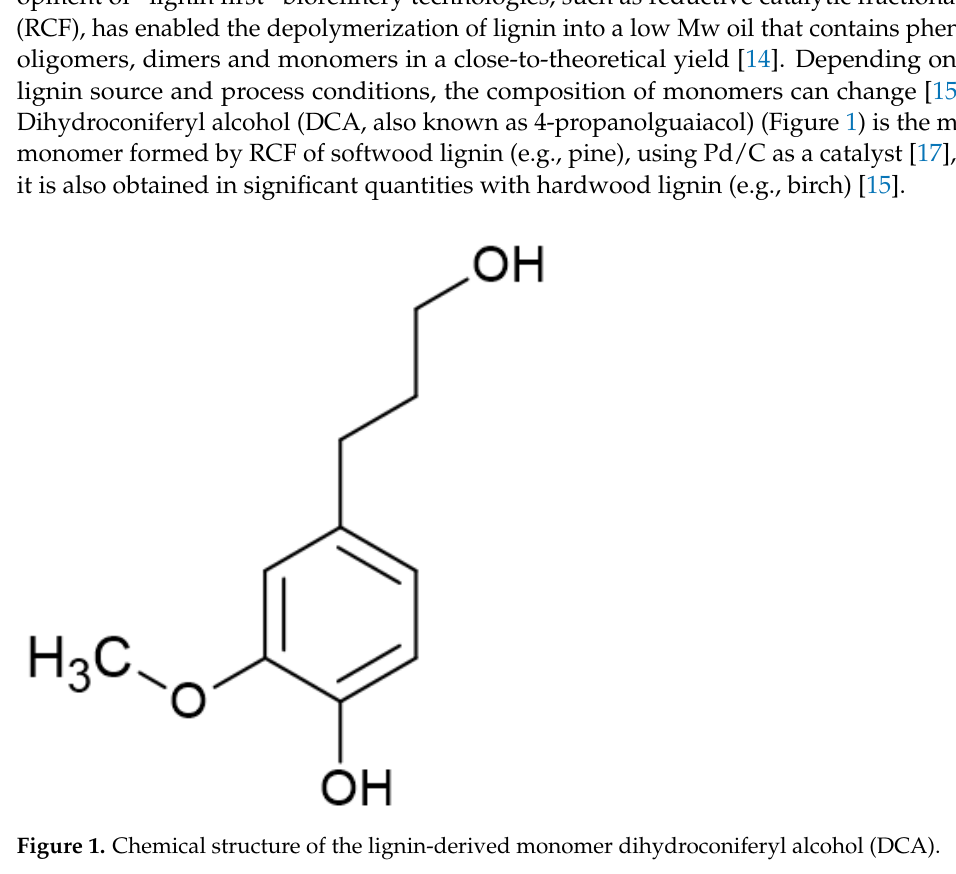
and phenyl ethanoids and propanoids [19–21].